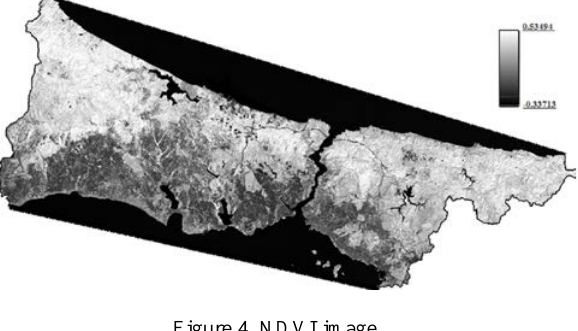
Figure 4. NDVI image.